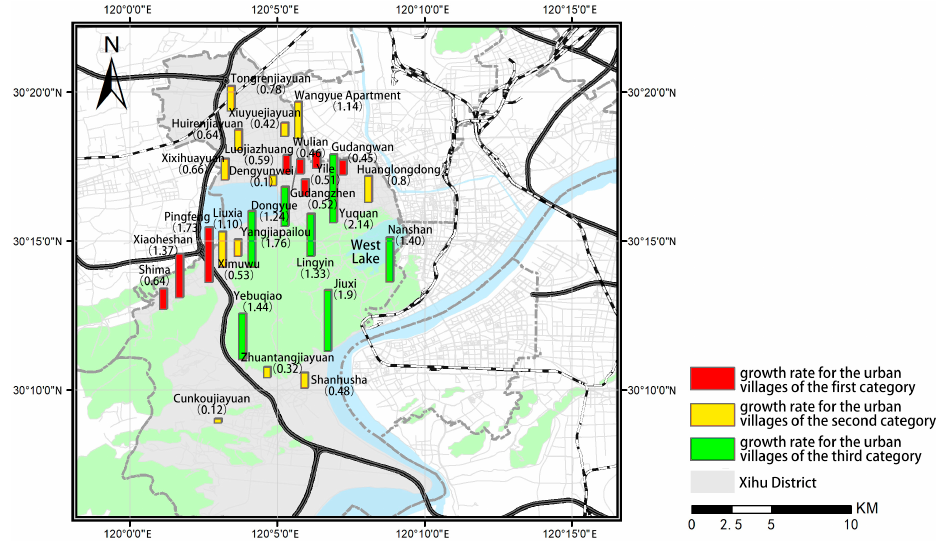
Figure 11. Spatial distribution of the growth rate for the urban villages of the three categories.